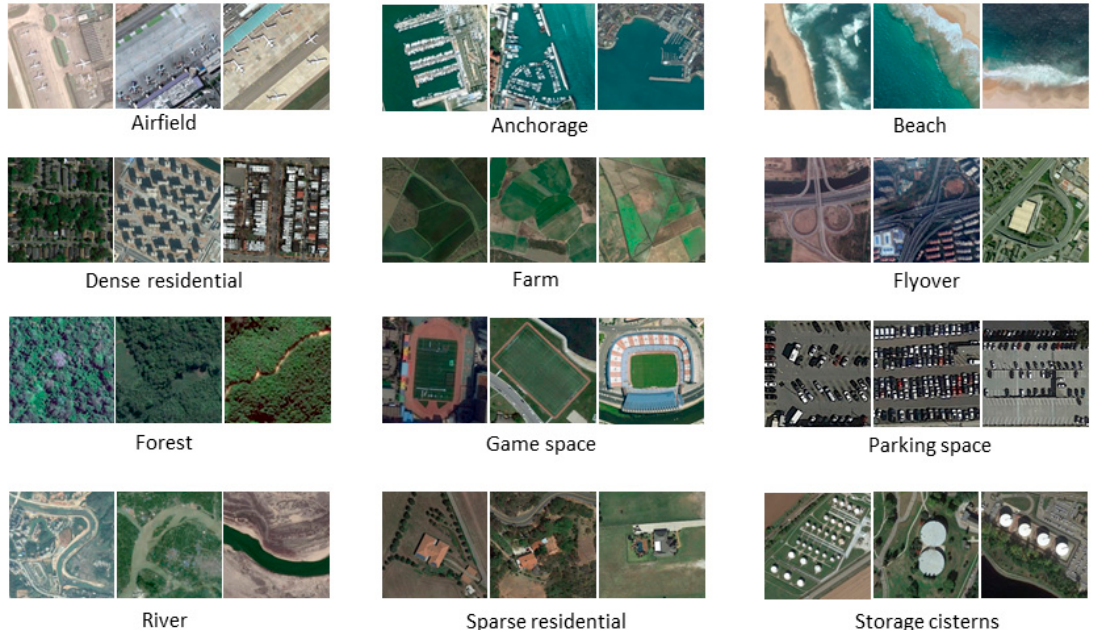
Figure 5. Example of images extracted from the AID dataset.